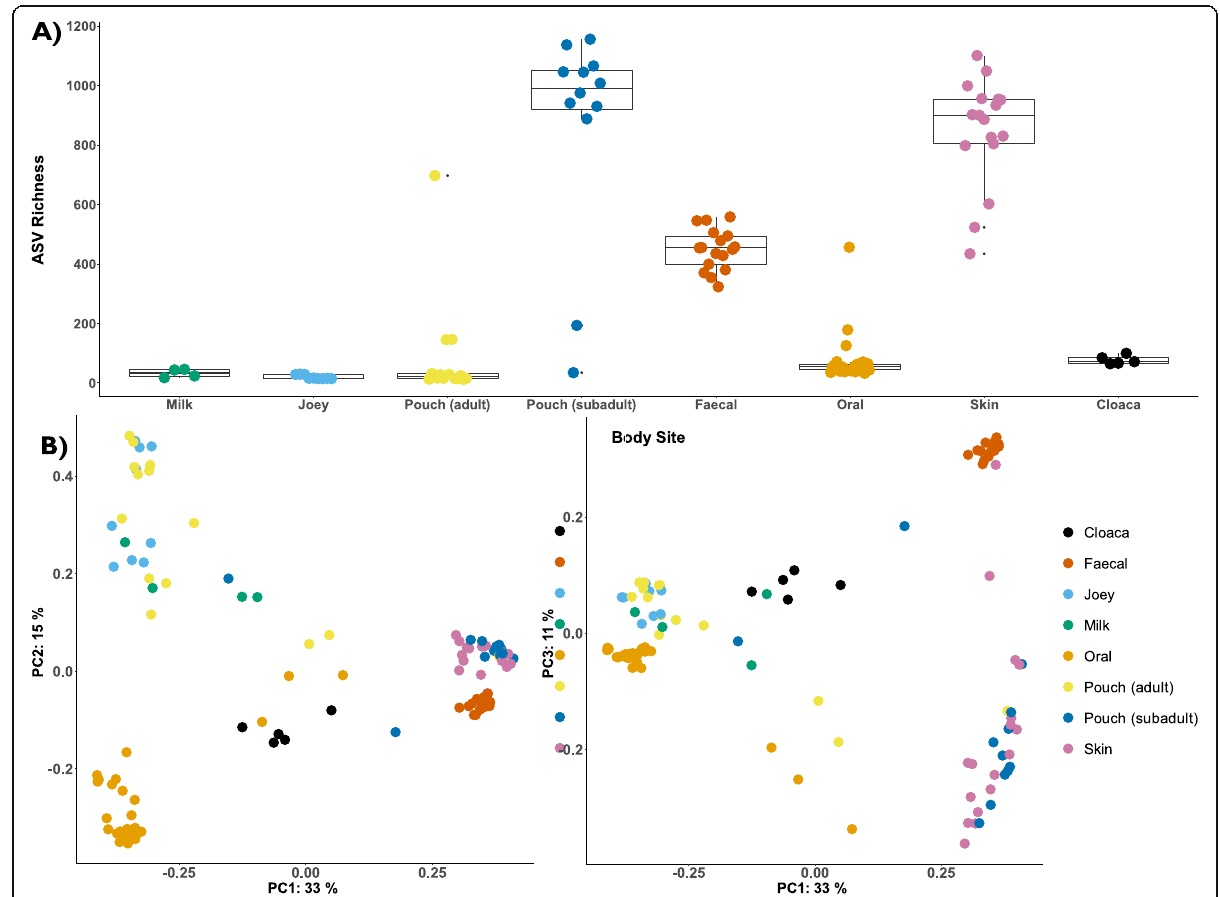
Fig. 4 Overall microbial diversity comparisons of all remaining samples in the dataset after decontamination and filtering ( n = 104), showing both oral ( n = 26), skin ( n = 17), cloacal ( n = 5), faecal ( n = 17), milk ( n = 4), joey skin, oral, and cloaca ( n = 9) and pouch samples divided into adult ( n = 14) and subadult ( n = 12) groupings. a Whisker-box plot showing the alpha diversity (richness) within each bodysite group. Horizontal lines in the boxes represent the median values; the lower and upper bound of boxes represent 25th and 75th percentiles, respectively. b Principal coordinates analysis (PCoA) plots based on the unweighted UniFrac distance matrix, portraying beta diversity between the different body site samples. The two plots display coordinates 1 versus 2 (left pane) and coordinates 1 versus 3 (right